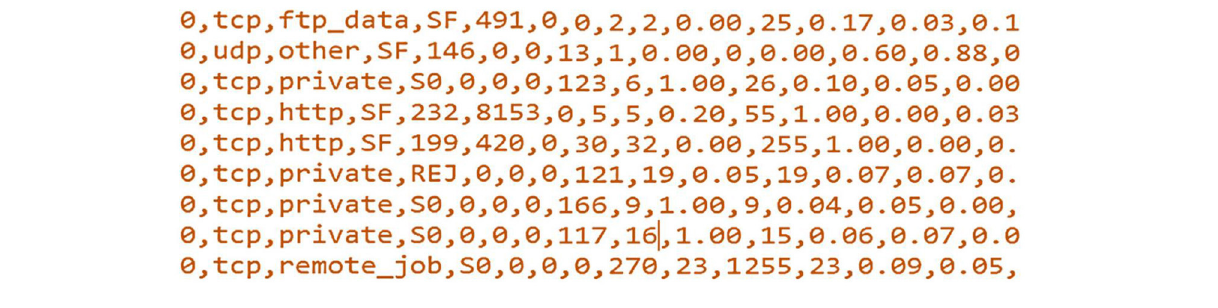
FIGURE 1 | Sample records of the NSL-KDD training data